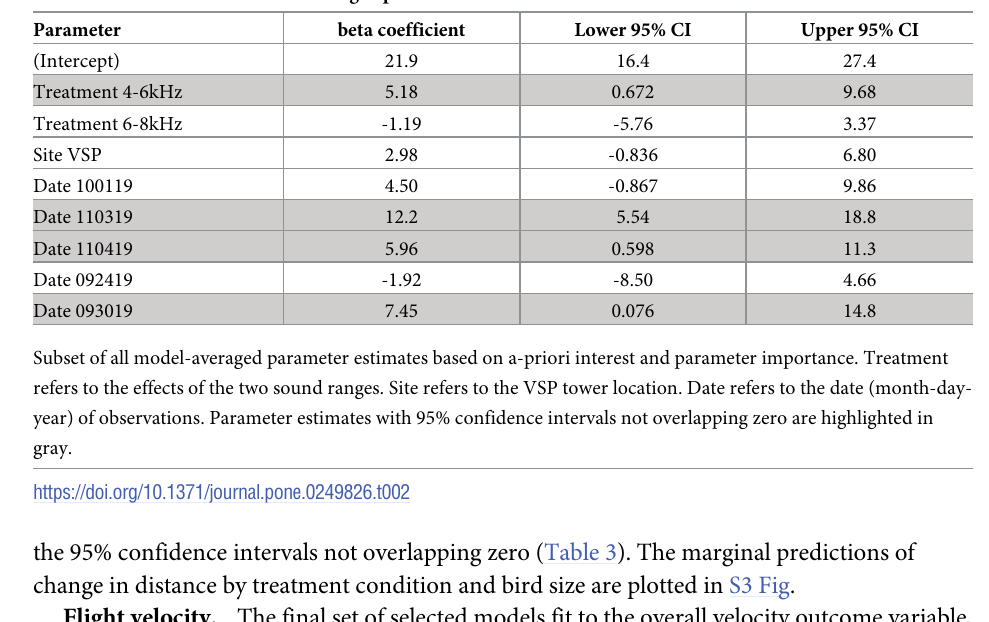
Table 2. Overall distance model-averaged parameter estimates. Parameter